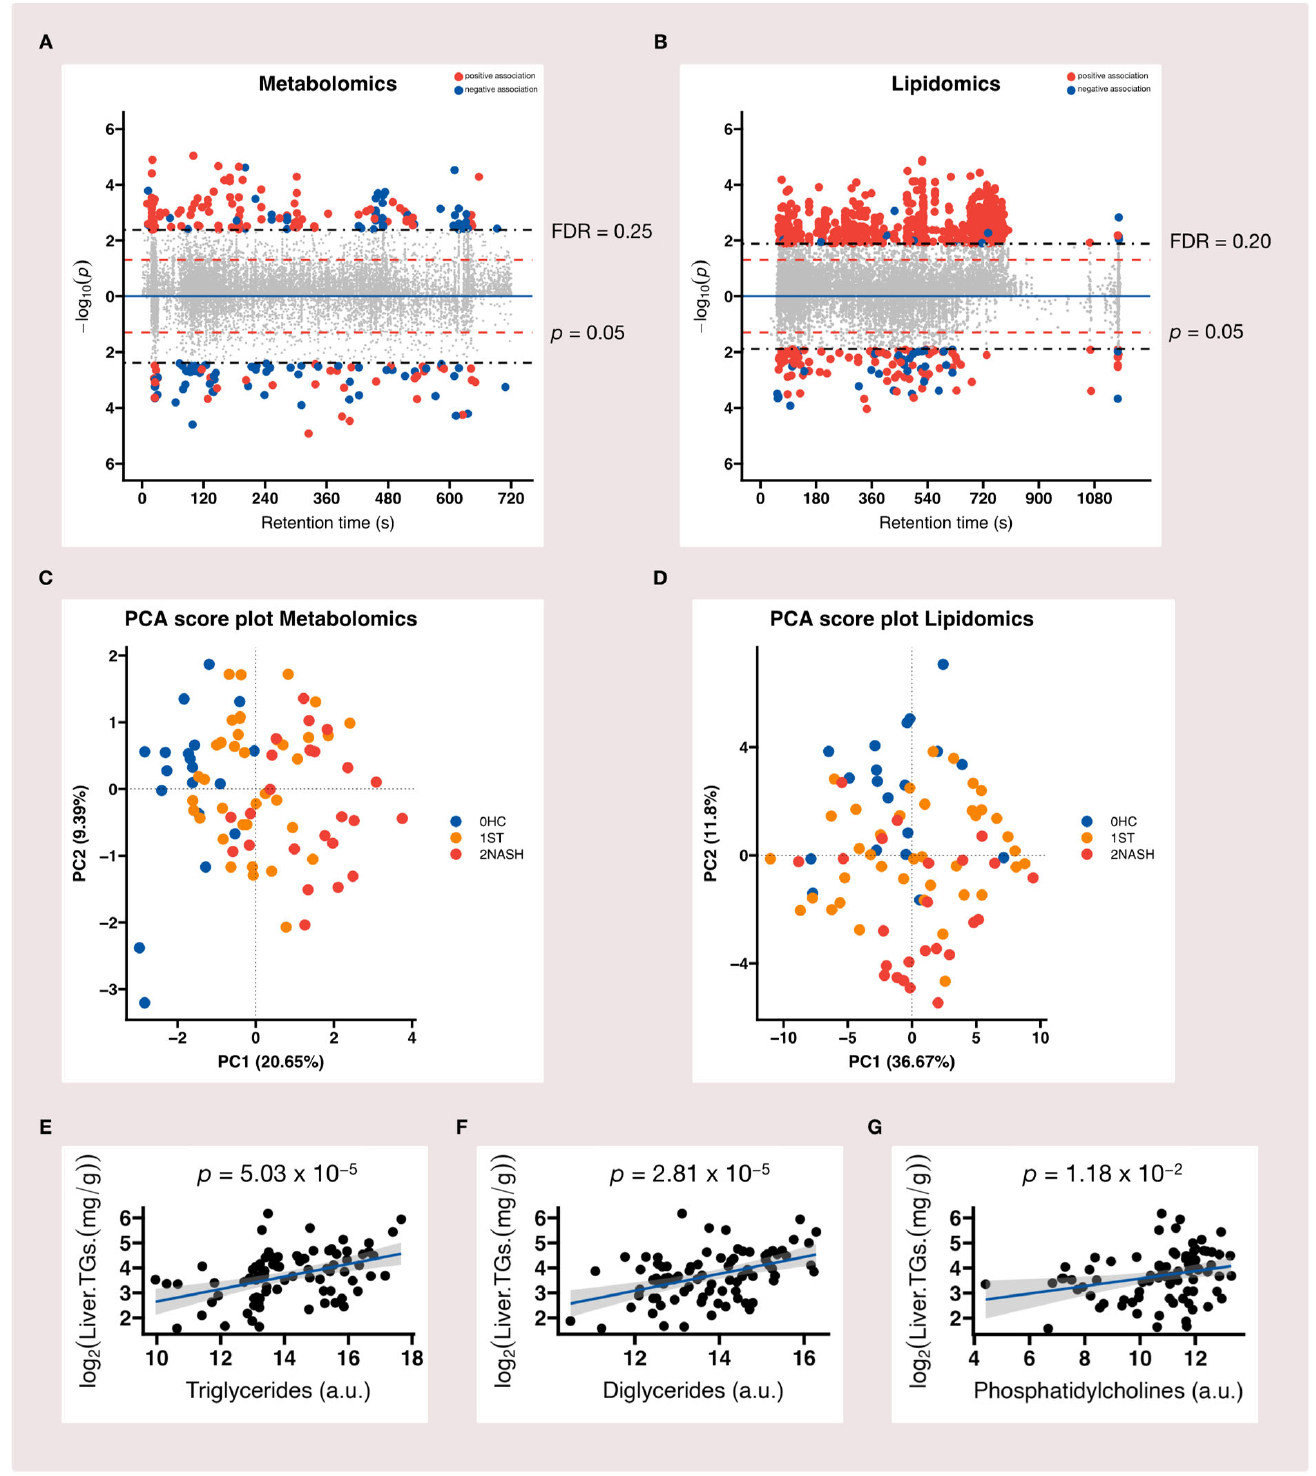
Figure 3. Our MAFLD metabolome ‐ wide association study: ( A ) MWAS highlighted 241 metabolomic features associated with the disease at FDR < 25%. ( B ) 787 lipidomic features were associated with the disease at FDR < 20%. The figure represents the retention time (s) of LC ‐ MS features detected in positive (above the blue line) and negative (below the blue line) ionization mode plotted against ‐ log 10 ( p ‐ value), respectively. Each dot represents a unique LC ‐ MS feature: red dots are features that positively associated with MAFLD, while blue dots are features that negatively associated with MAFLD. The “dashed” red horizontal line indicates the raw p ‐ Value of 0.05 and the “dot– dash” horizontal line shows the false discovery rate ‐ adjusted q ‐ Value of 0.2 for lipidomics and 0.25 for metabolomics; ( C , D ) the PCA score plots for the metabolomic and lipidomic data, respectively; ( E – G ) the three main lipids that matched the top 10 ranked features based on the regression p ‐ value and correlation with liver TG content.